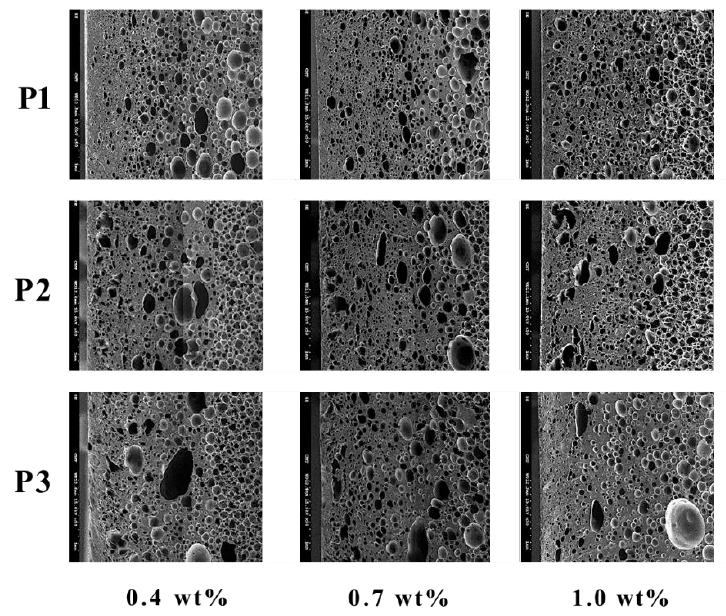
Figure 6. The effect of different SCF dosages on foaming morphology. Table 6. Averaged cell density at different SCF Table 4. Averaged cell density at different mold temperatures. Mold Temp.